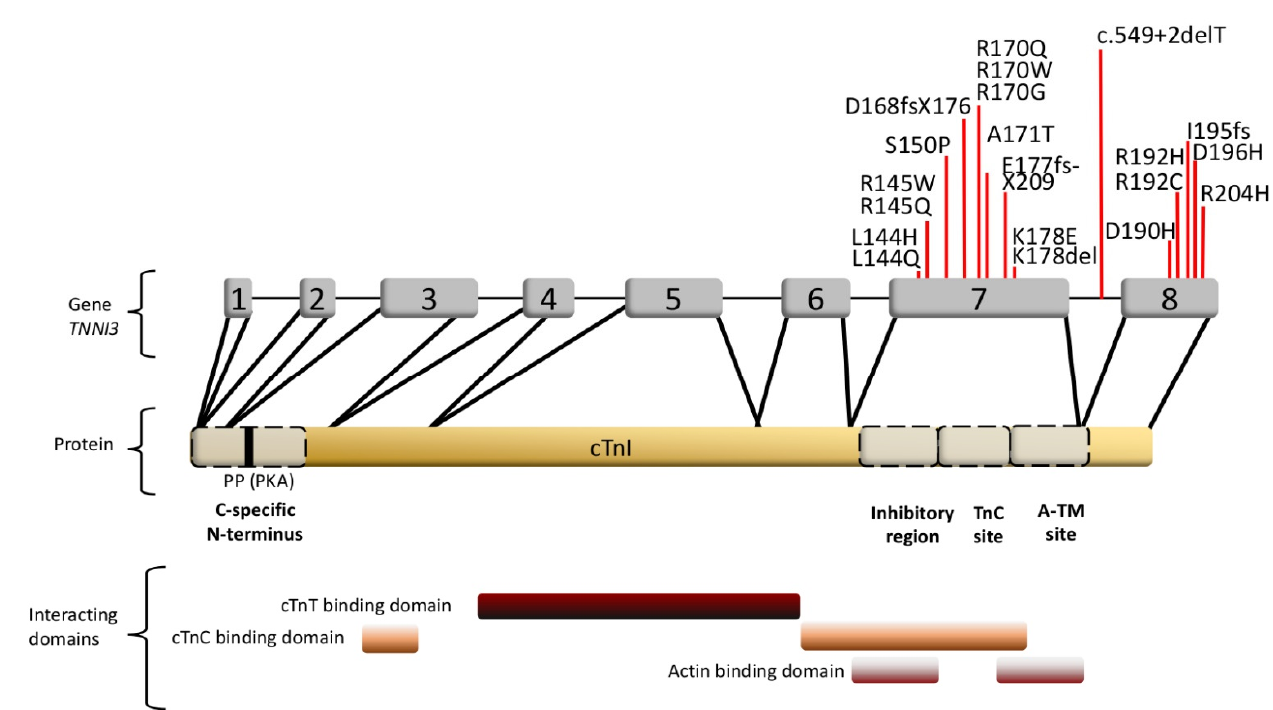
Figure 4. cTnI organization. Exons, RCM mutations and binding sites are indicated. A-TM: a second actin-tropomyosin binding site, PP (PKA): Serines 22, 23 phosphorylated by the proteinkinase A (PKA). The RCM mutations mainly affect exon 7 and 8, encoding for the inhibitory region, TnC binding domains and the A-TM site. The figure was created using PowerPoint (Microsoft).